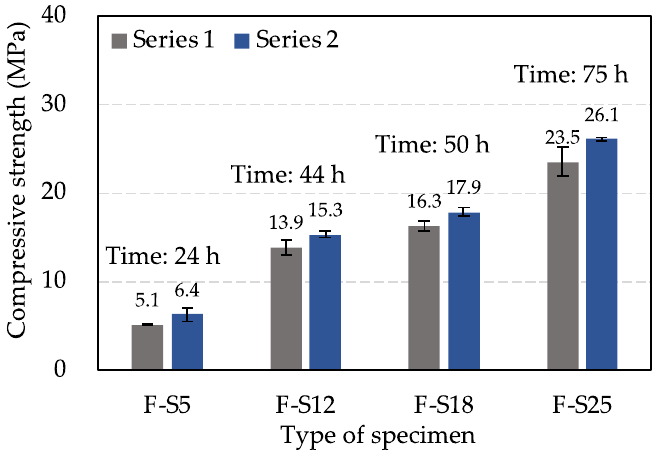
Figure 3. Determination of compressive strength after specified curing time.